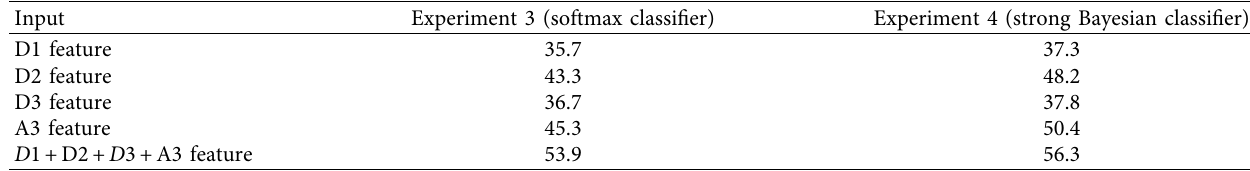
Table 2: Influence of shape feature on classification accuracy.